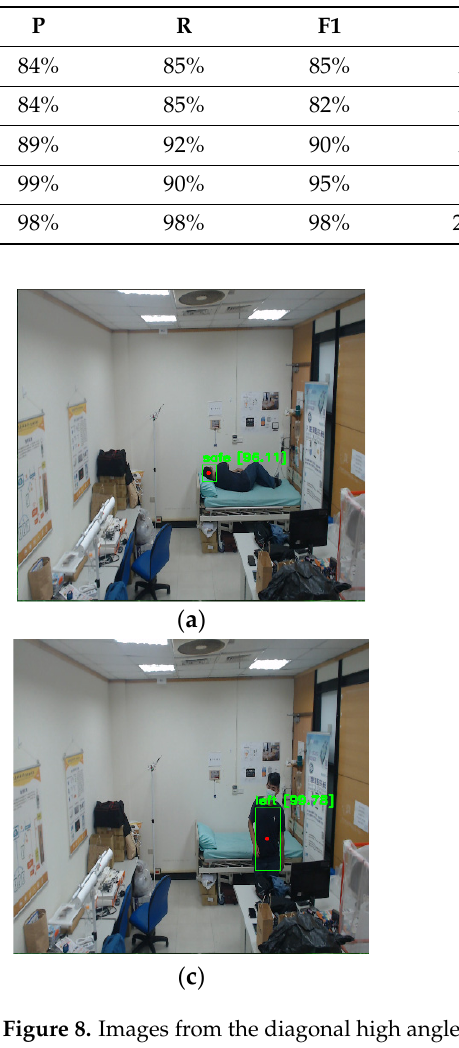
Table 2. Object detection statistical results for different camera angles.